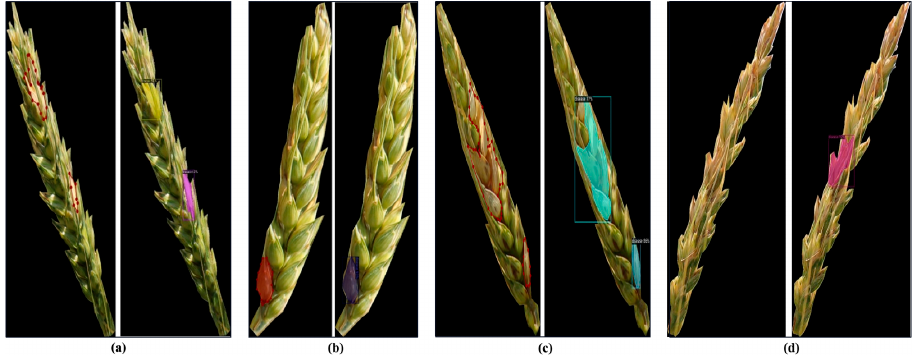
Figure 6. Illustration of diseased area detection and segmentation results from the individual wheat spikes in test set: ( a ) diseased areas with shadow; ( b ) diseased areas under strong light; ( c ) diseased areas under low light; ( d ) diseased areas under awn occlusion.